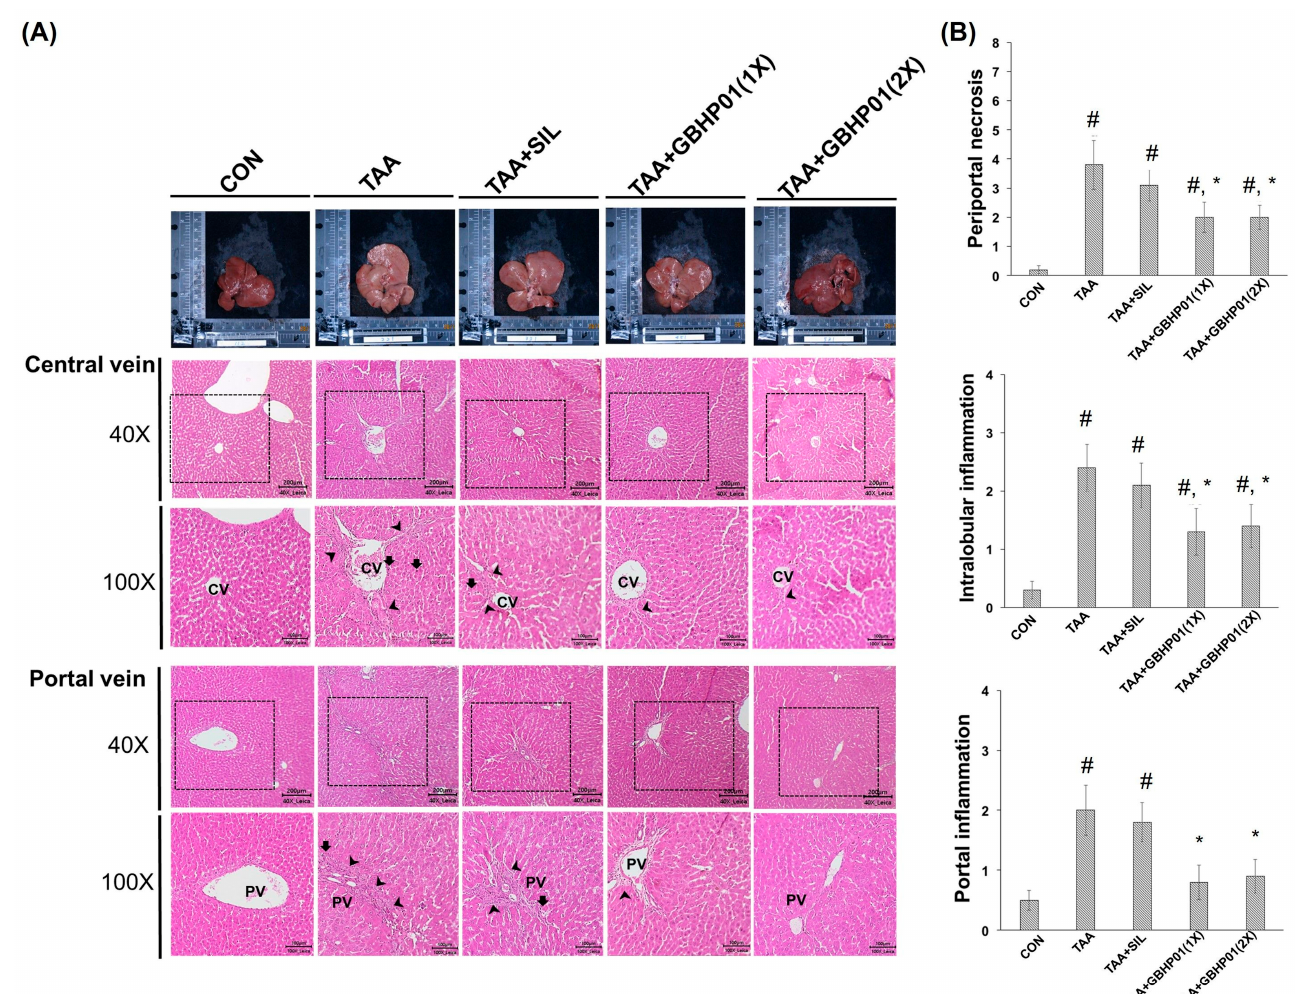
Figure 1. Effects of chicken liver hydrolysate-based supplement (GBHP01 TM ) on ( A ) the gross appearance and H&E stained illustrations of liver tissues of experimental rats (40 × and 100 × ) and ( B ) the scores of HAI: periportal necrosis, intralobular inflammation, and portal inflammation. Data are given as mean ± SEM (n = 8). #: Signifcance against CON group ( p < 0.05); *: Signifcance against TAA group ( p < 0.05).